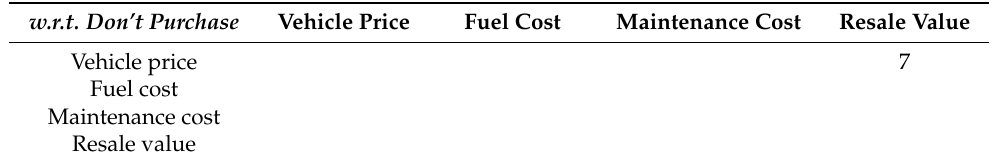
Table 11. Pairwise comparison matrix of sub-criteria of COST OF OWNERSHIP with respect to DON’T PURCHASE decision.